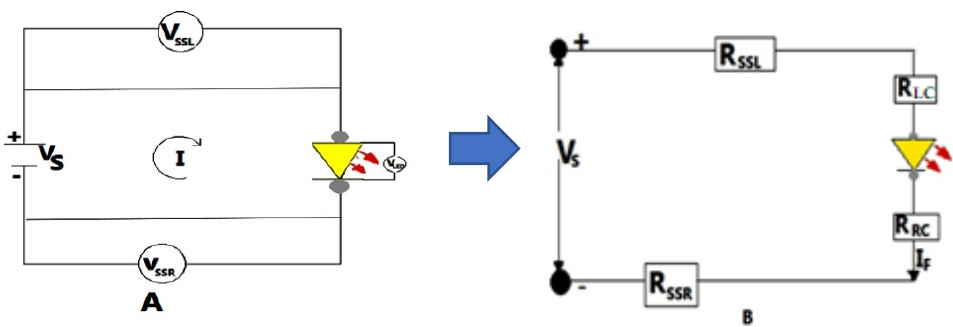
Figure 4. Schematic diagram of the LED connecting into SS conductive yarn ( A ) and total resistance measurement setup ( B ).